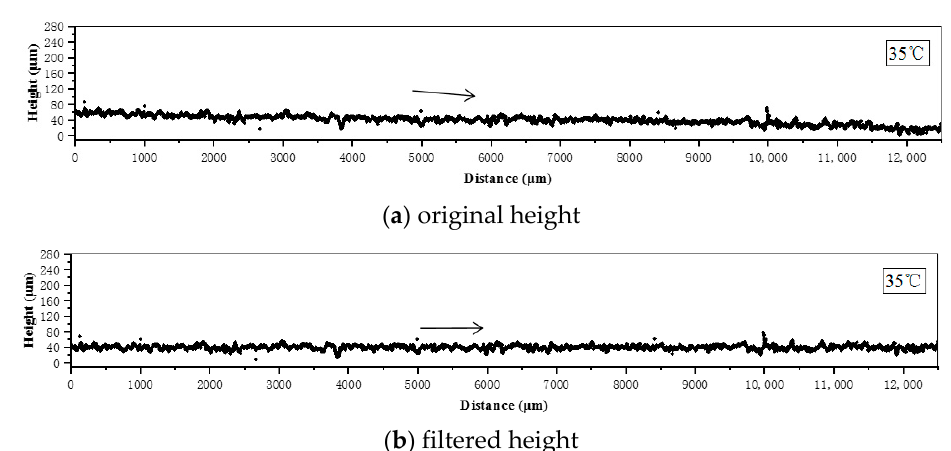
Figure 5. The original heights and the filtered heights ( h es ) at A position (1 mm to bloom edge) in the outer curve side (O) under 35 °C superheat: ( a ) original height, ( b ) filtered height. (The measuring length is 12.5 mm, and there are 50,001 points with 0.25 μ m intervals along the distance. The arrow line represents the whole changing trend with the distance).